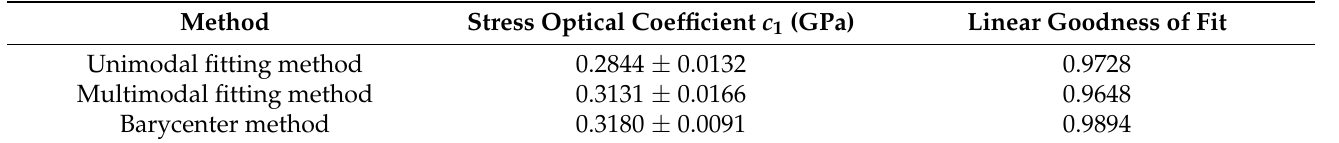
Table 1. Processing results for measurement experiments.